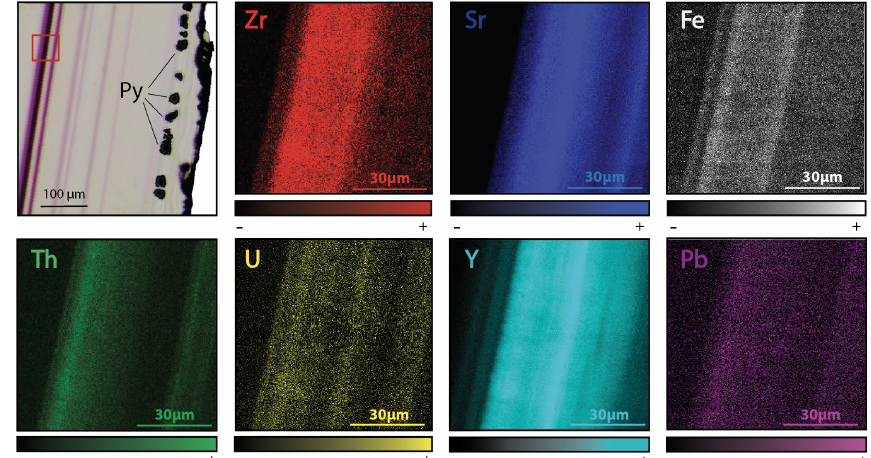
Figure 10. Transmitted plane-polarized light photography from PP18S7 and corresponding synchrotron X-ray fluorescence elemental maps. The area of the XRF scan is outlined by a red box on the photograph. Map dimensions are 80 ×